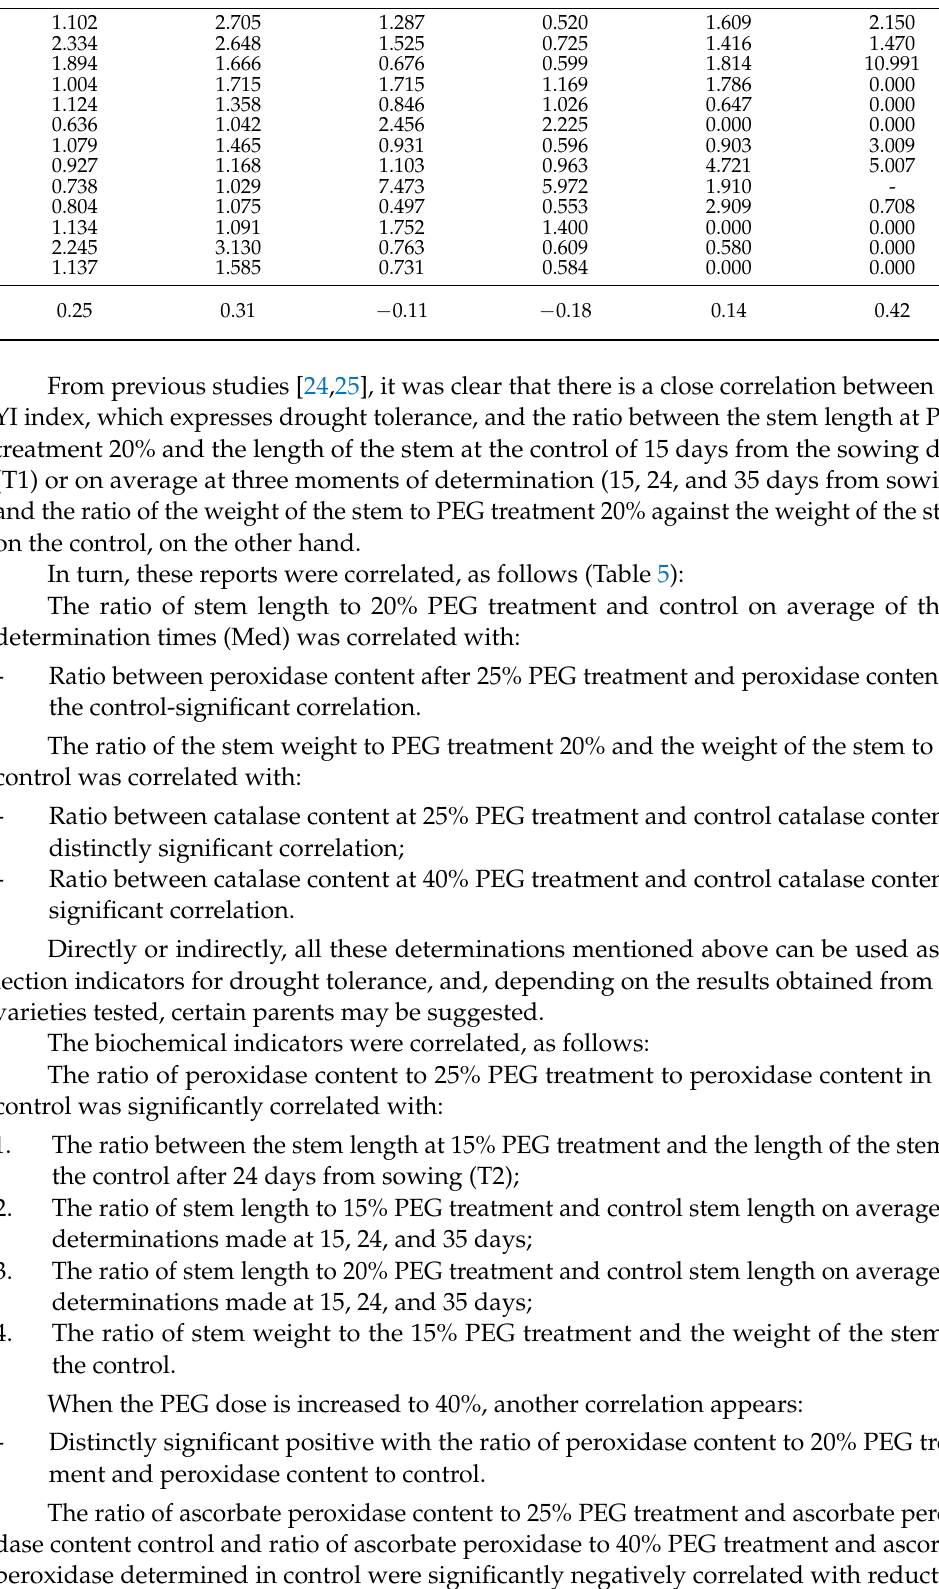
Table 4. The correlation between the YI index and the antioxidant activity for the limited assortment. Ratio PEROX Ratio PEROX Ratio ASC Cultivar YI PEG 25%/ct PEG 40%/ct PEG 25%/ct GLOSA